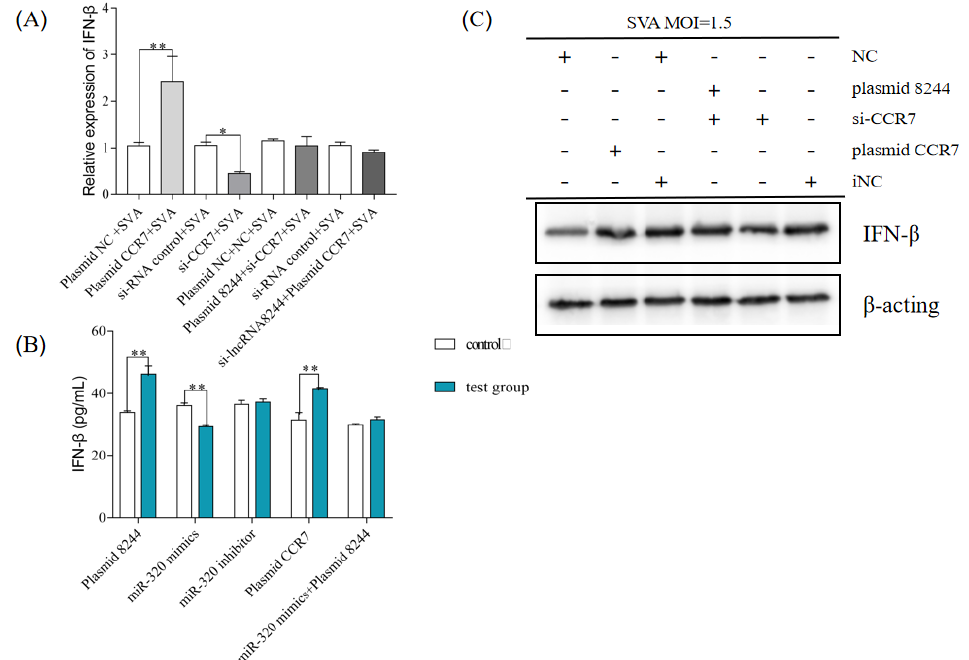
Figure 8. CCR7 can promote the expression of IFN- β ( A ) PK-15 cells were transfected or co-transfected with plasmid NC/plasmid CCR7/iNC/si-CCR7/plasmid NC and NC/plasmid 8244 and si-CCR7/iNC and iNC/si-lncRNA 8244 and plasmid CCR7 for 24 h. The expression level of IFN- β was determined by real-time RT-PCR assay and Western blot ( B ). The mRNA level of IFN- β was normalized to mRNA level of GAPDH or ELISA ( C ). All data are represented as mean ± SD with three replicates. * p < 0.05; ** p < 0.01.